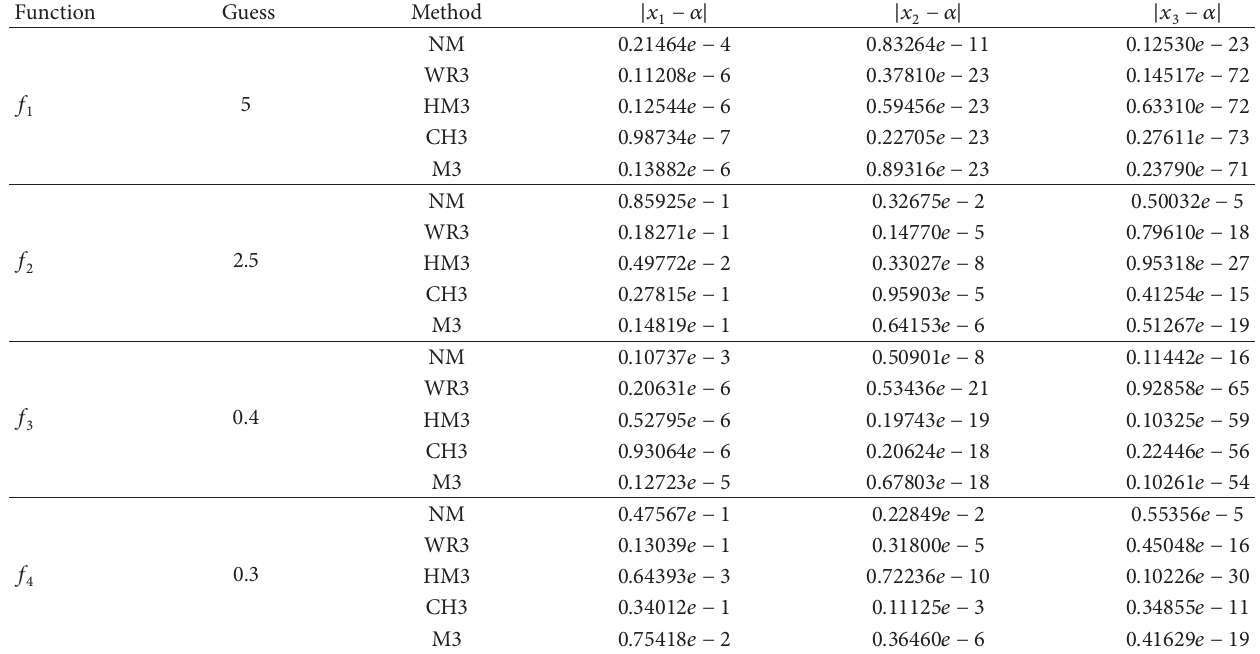
Table 2: Comparison of the absolute error occurring in the estimates of the exact root. Function